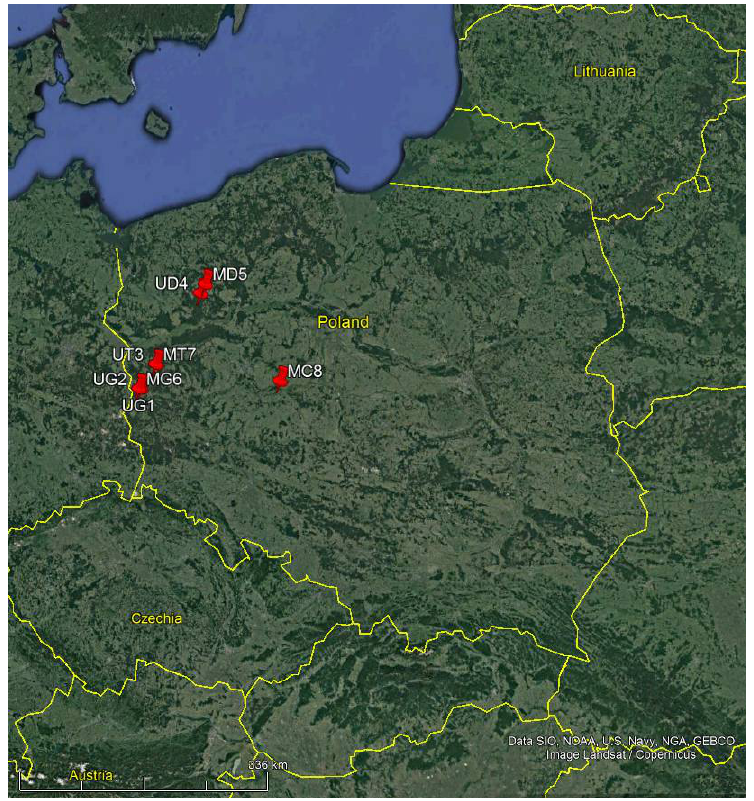
Figure 1. Locations of experimental sites. Source: Google Earth Pro 7.3.4.8248 (64-bit) Data SIO, NOAA, U.S. Navy, NGA, GEBCO. Image Landasat / Copernicus (2021) [56].